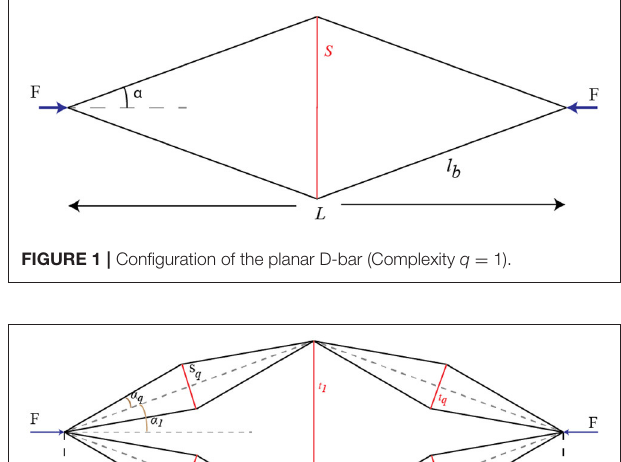
2. t q and s q are the tension and =